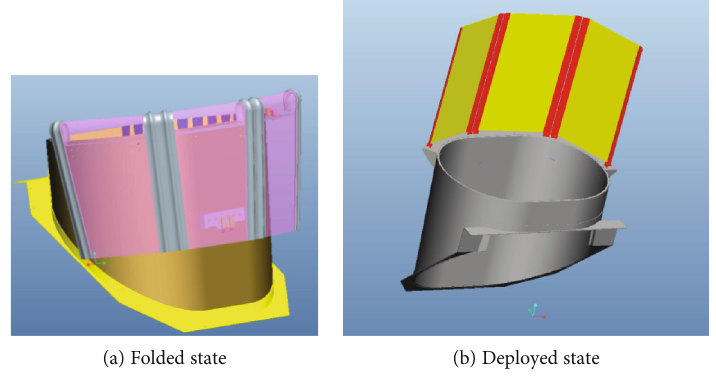
Figure 1: Self-deployable sunshield.